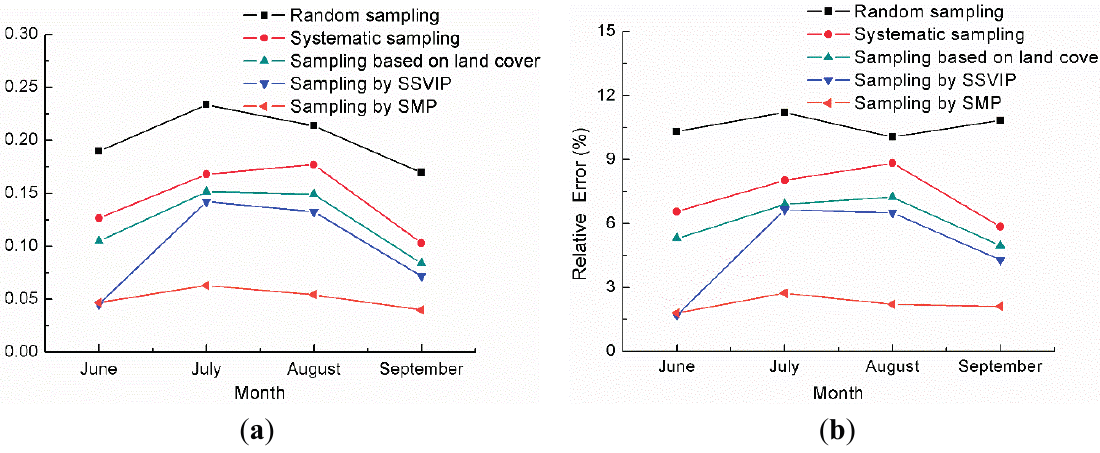
Figure 8. The ( a ) RMSE and ( b ) average relative error (RE) between the aggregated LAI reference maps generated by different sampling strategies and the reference data with 30 ESUs from June to September